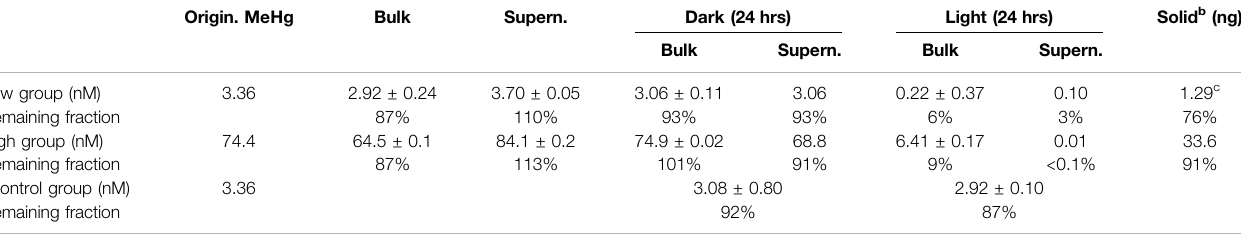
TABLE 2 | Testing results of the reaction of MeHg and L-cysteine capped CdSe NPs. Most results refer to the MeHg concentrations derived from Tekran 2700. Origin. MeHg